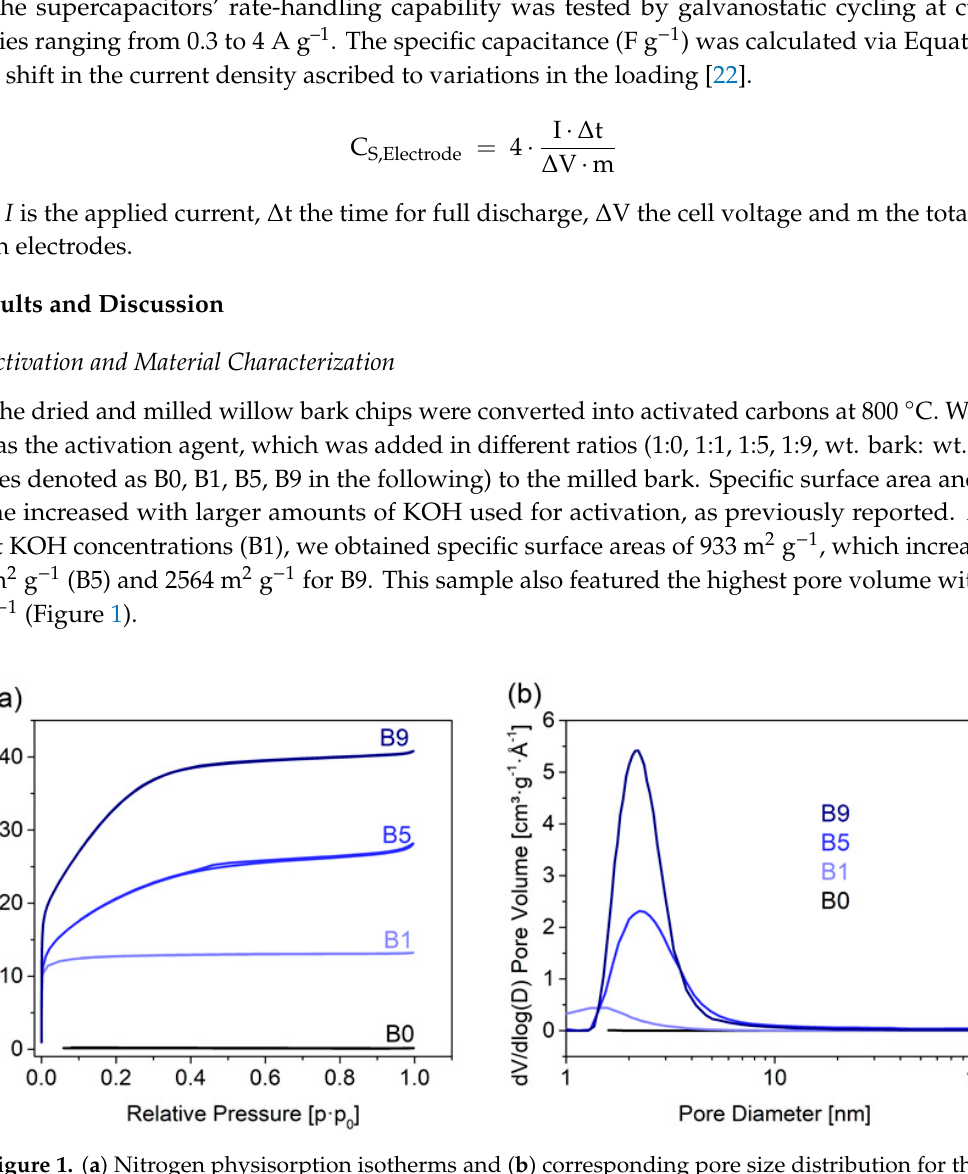
Figure 1. ( a ) Nitrogen physisorption isotherms and ( b ) corresponding pore size distribution for the willow bark and all three activated samples.